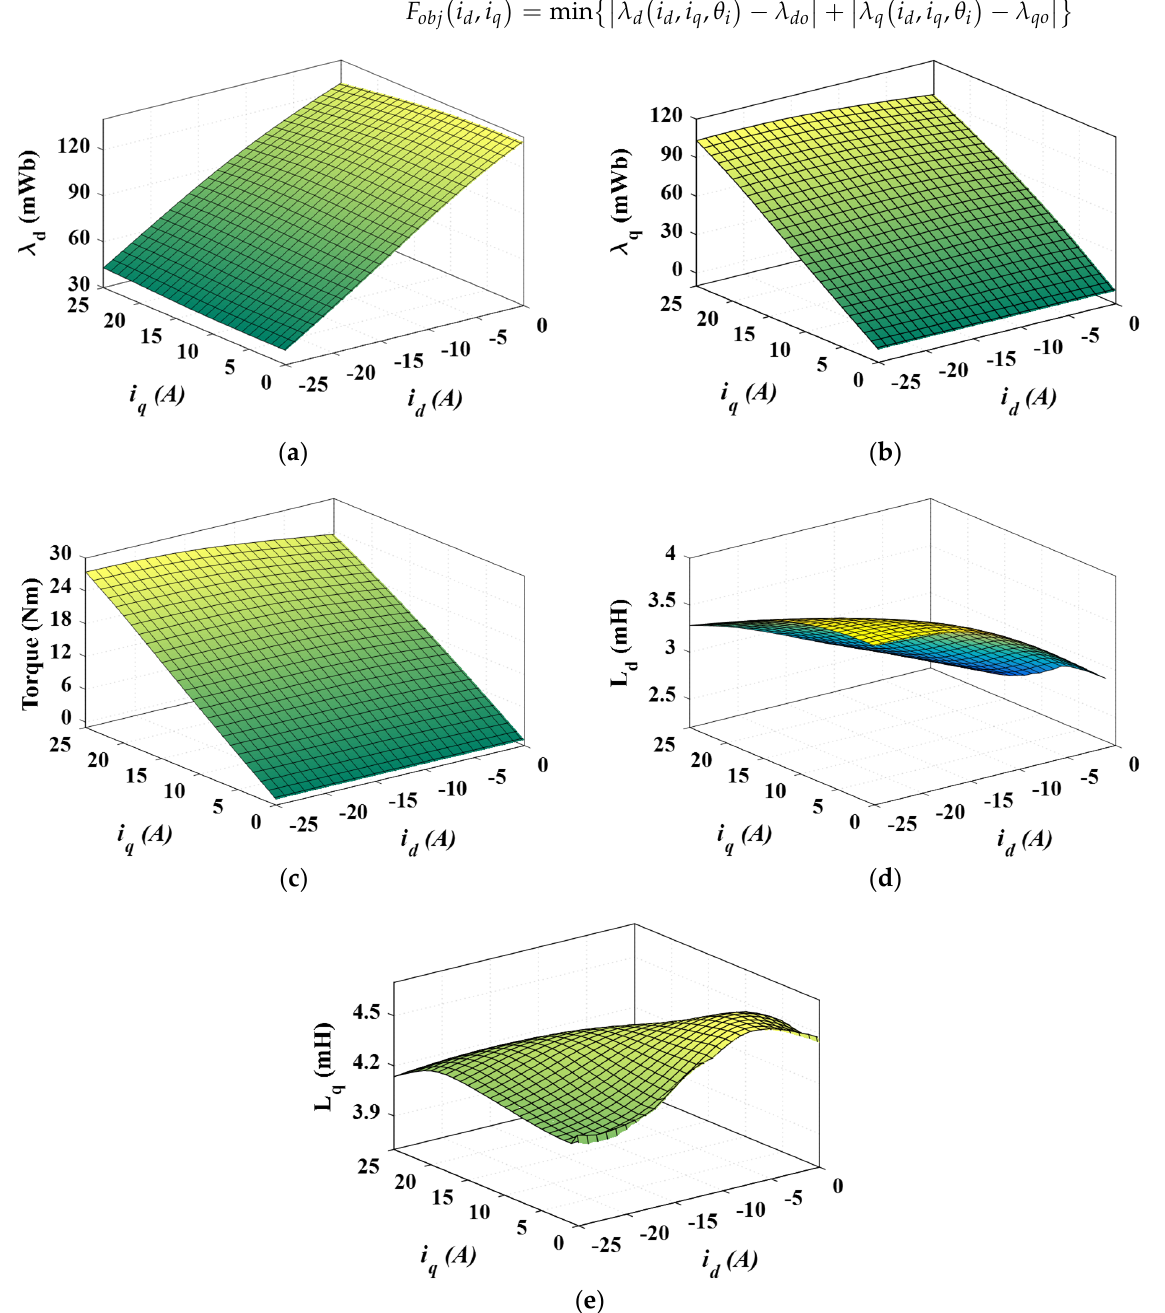
Figure 6. The FEA-calculated ( a ) λ d , ( b ) λ q , ( c ) torque, ( d ) L d , and ( e ) L q .